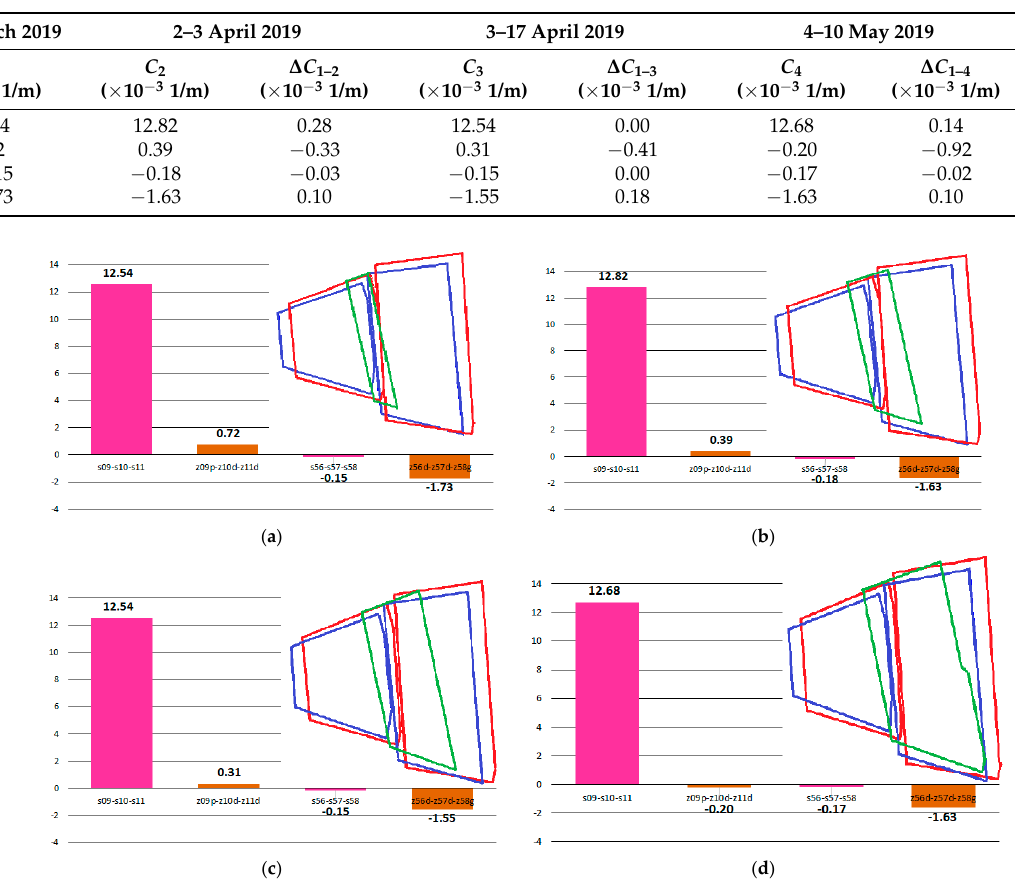
Table 4. The values of curvatures and their changes observed on two neighboring sections in the Table 4 and Figure 9 present the values of curvatures from March 19. time period of March–May 2019.